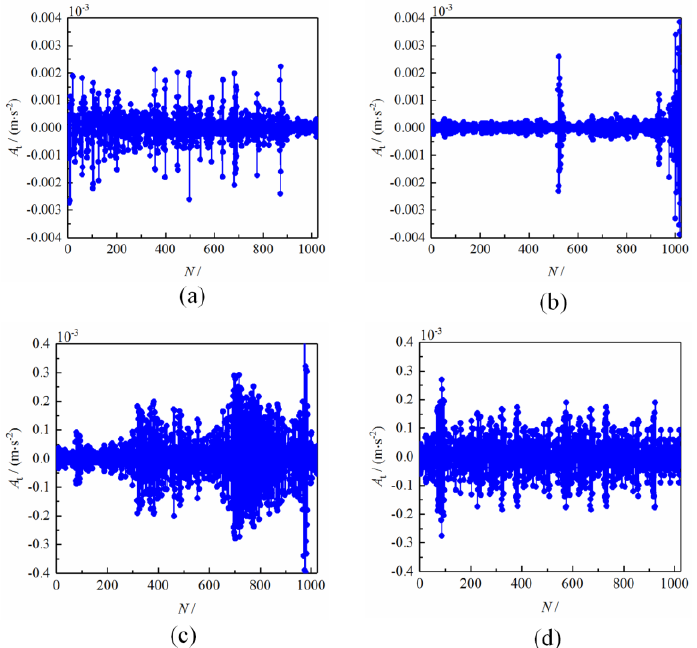
Figure 6. Time-domain characteristics of the vibration signal. ( a ) Single water phase, ( b ) Oil – water two-phase, ( c ) Gas – oil – water mixing phase, ( d ) Single gas phase. two-phase, ( c ) Gas–oil–water mixing phase, ( d ) Single gas